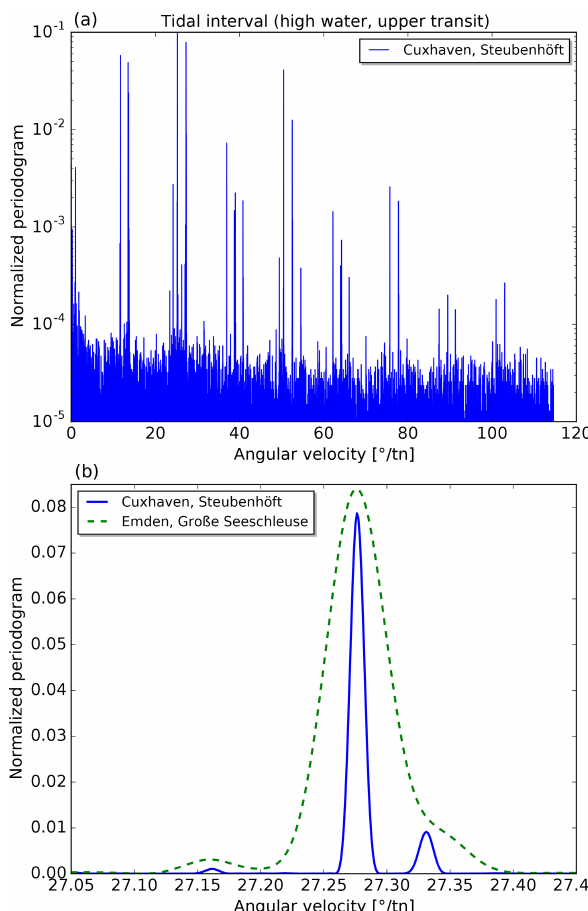
Figure 2. (a) Normalized periodogram of the lunitidal intervals of high waters (assigned to upper lunar transits) for the tide gauge Cuxhaven. Notice the upper part of the logarithmic scale is trun- cated at 0.1 for better visibility of weak lines. (b) Zoomed-in view of the region with the spectral line corresponding to half a tropical month (Mf) at 27.2764618 ◦ tn − 1 . The longer time series for Cux- haven leads to narrower spectral lines (solid blue curve) compared to Emden (dashed green